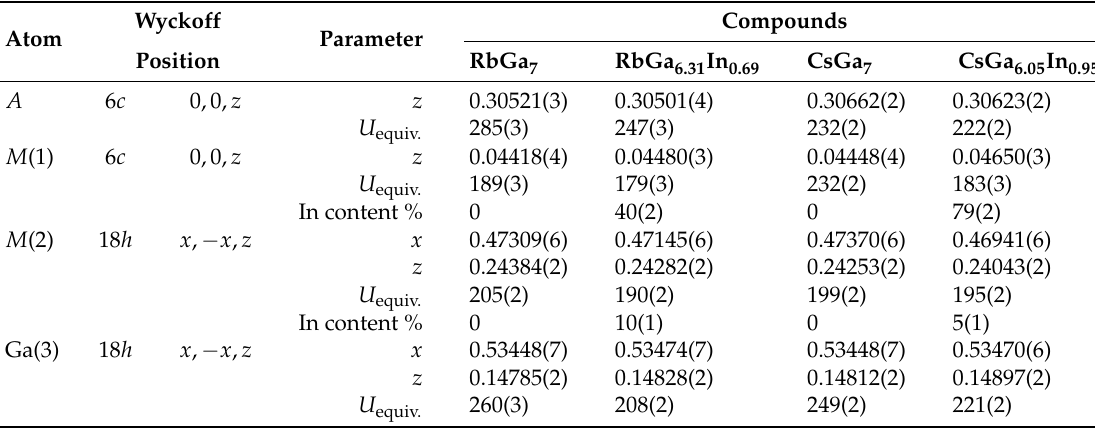
Table 3. Atomic coordinates and equivalent isotropic displacement parameters/pm 2 for the crystal structures of the RbGa -type gallides. 7